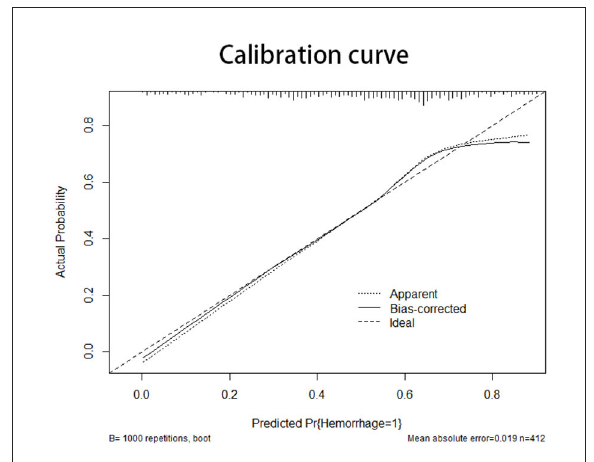
FIGURE3 The X-axis of the calibration curve shows the predicted probability, and the Y-axis shows the actual probability. The calibration curve represents the performance of the nomogram in internal validation. The diagonal line represents the ideal model of prediction; the closer the curve is fitted to the diagonal line, the better the model performs.